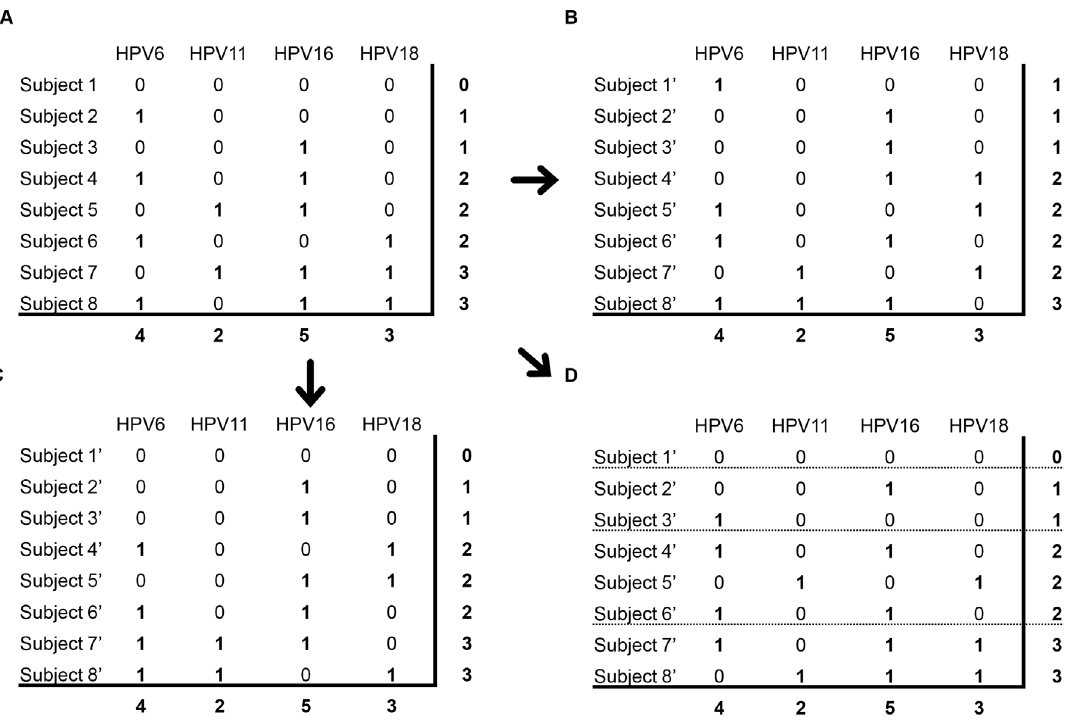
Figure 1. An abbreviated example of matrix randomizations. The observed data ( A ) of HPV infection status is organized in binary matrix indicating type-specific infection status. To generate expected models, data are randomized while preserving column sums (null model; B ) or row and column sum (non-strata model; C ). Additionally data were stratified by HPV types per person (k-strata model 2; D ) or/and study data source (study and study-k strata models; not shown) with randomization restricted to within each strata.